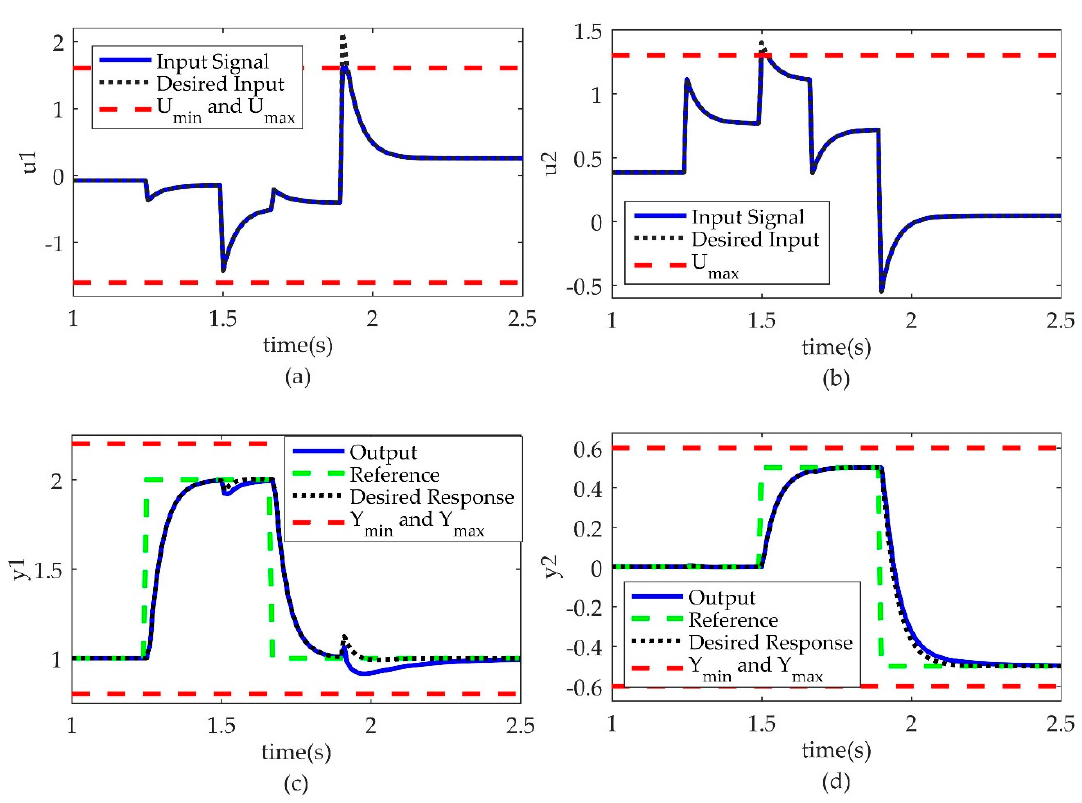
Figure 2. Closed-loop responses for different dead time cases. ( a ) The first control signal; ( b ) the second control signal; ( c ) the generator terminal voltage output; ( d ) the generator load angel output. The results above show the effectiveness of the proposed method.